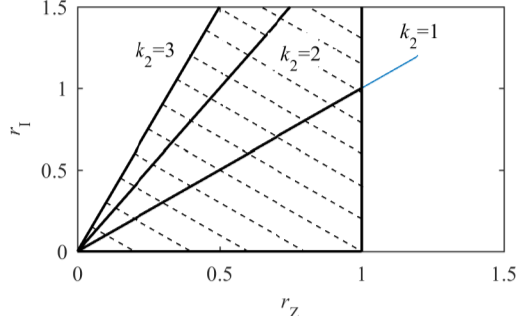
Figure 6. Non-detection zone (NDZ) of the proposed method.